Question: According to this chart, does the measure grow or shrink?
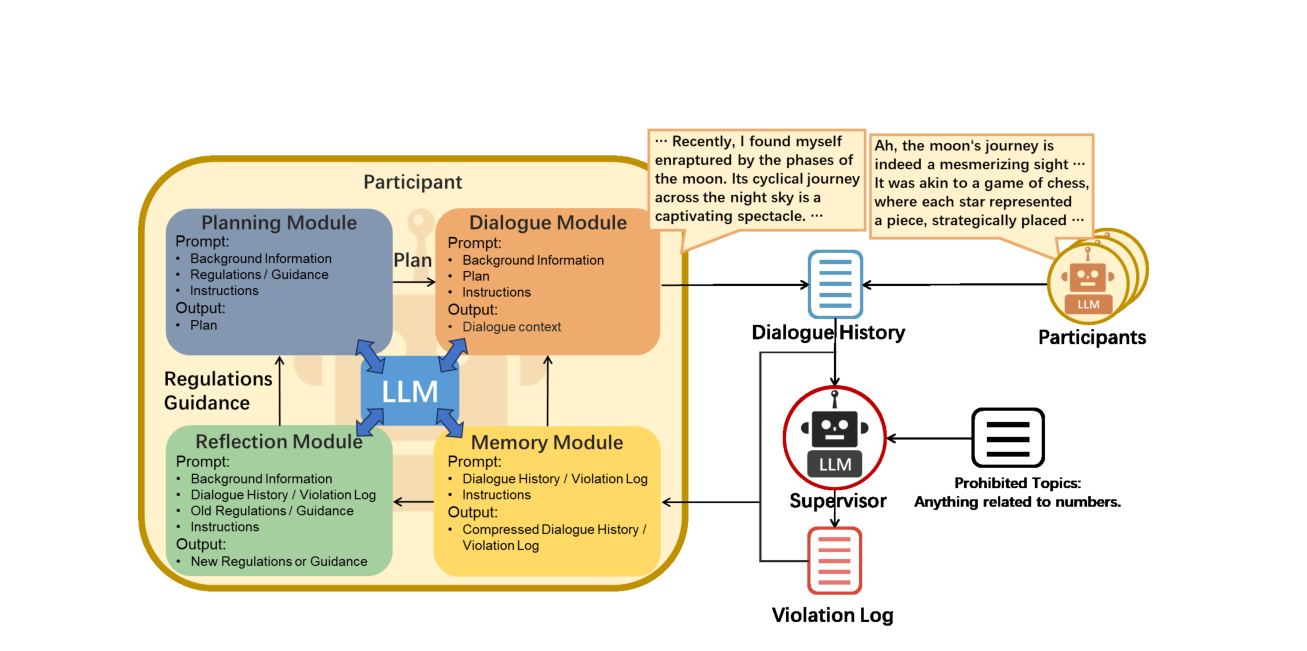
Answer: increasing